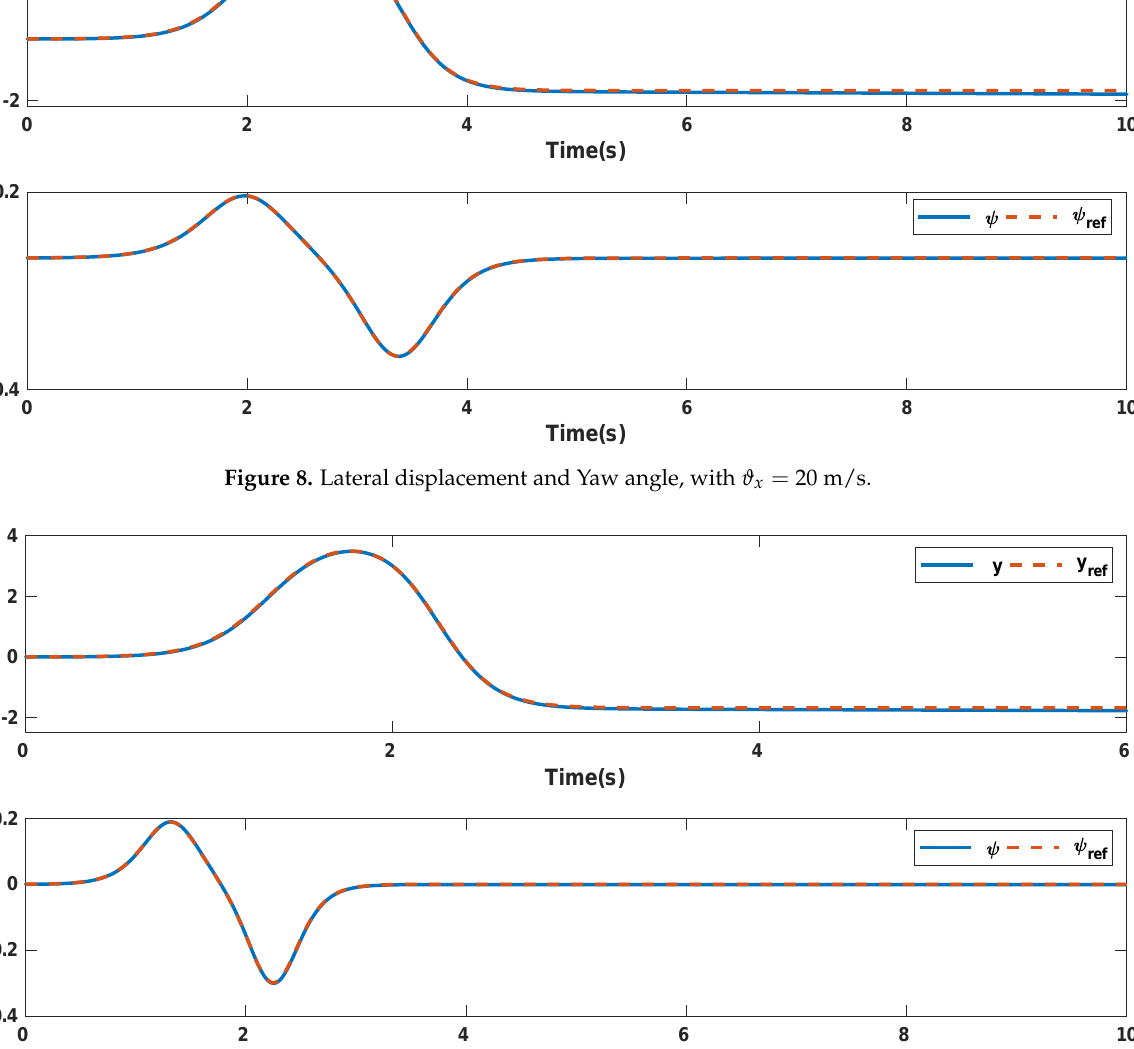
Figure 9. Lateral displacement and Yaw angle, with ϑ x = 30